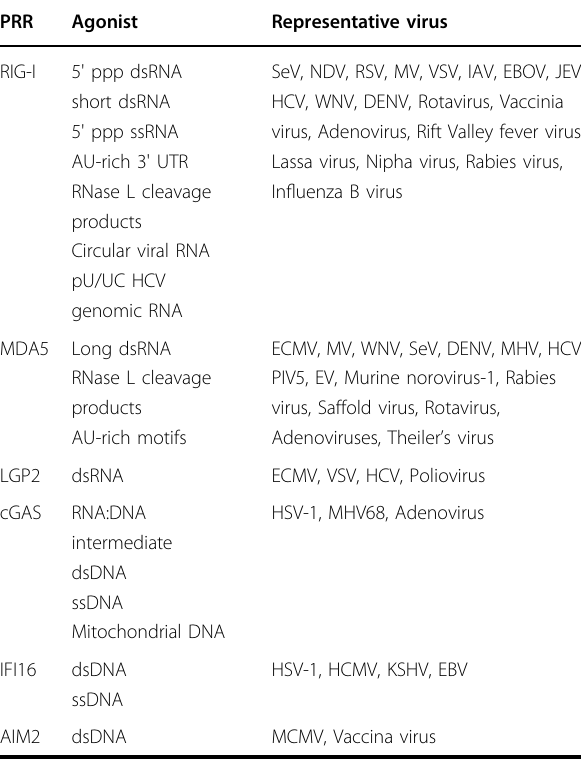
Table 1 Summary of RNA and DNA viruses and ligand recognition by